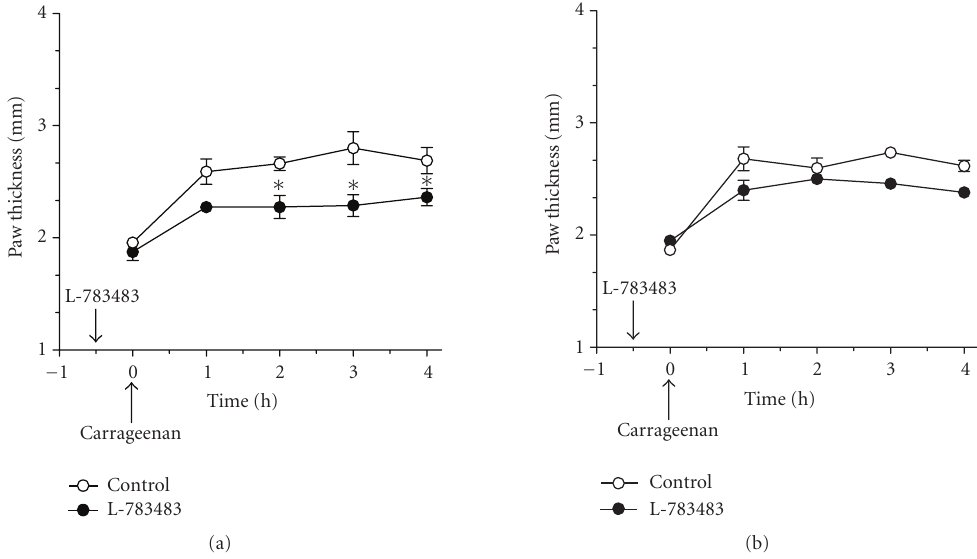
Figure 3: Antiedema e ff ect of the PPAR δ agonist L-738483 on carrageenan-induced paw edema in wild-type and hepatocyte-specific RXR α - deficient mice. Wild-type (a) and hepatocyte-specific RXR α -deficient mice (b) were treated intraperitoneally with (100 mg/kg) of L-738484, 30 minutes before induction of inflammation. As indicated by the arrow, carrageenan (1%, intraplantar) was injected at t = 0. Carrageenan- induced edema is reflected by an increase in paw thickness. Values represent mean ± SEM. n = 3–5 mice per group. ∗ P < . 05 versus corresponding wild-type